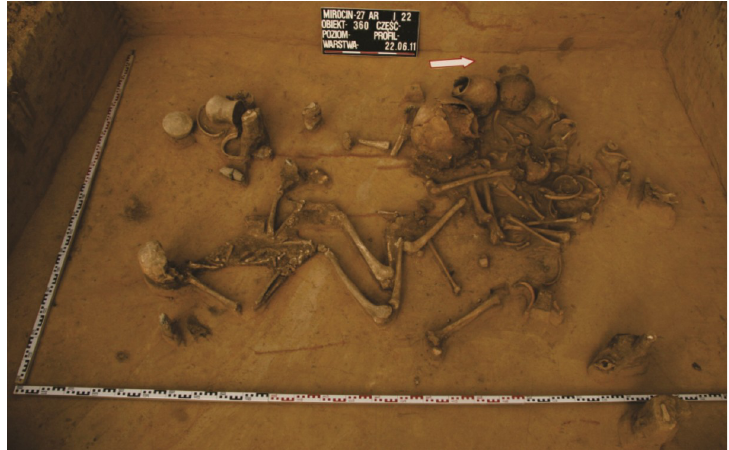
Fig 3. Double grave no. 360 from Mirocin, site 27 –distribution of skeletons and grave